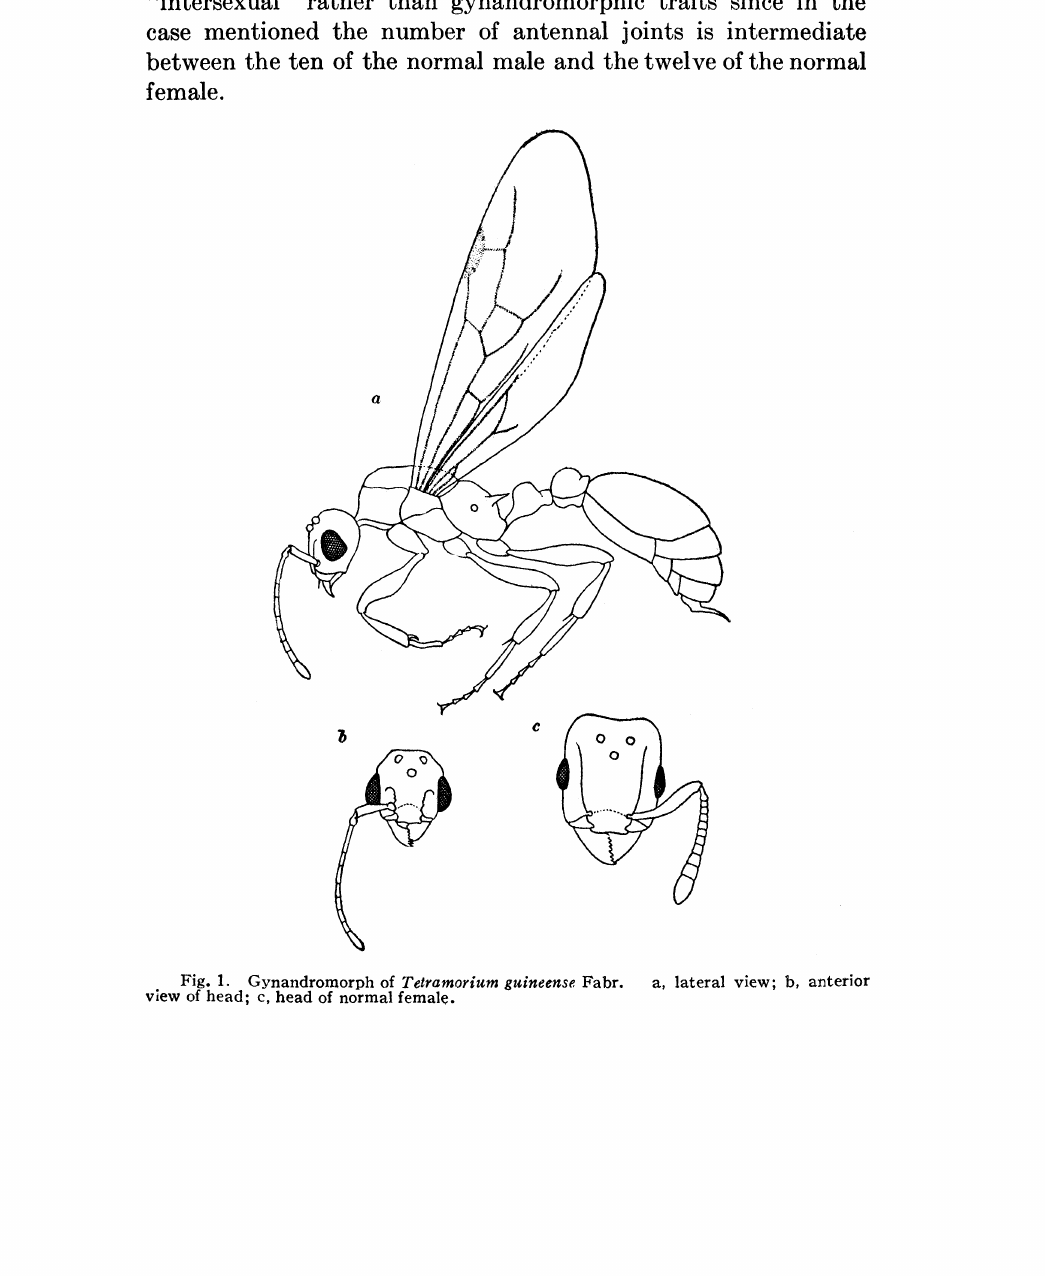
Fig. 1. Gynandromorph of Tetramorium guineense Fabr. a, lateral view; b, anterior view of head; c, head of normal